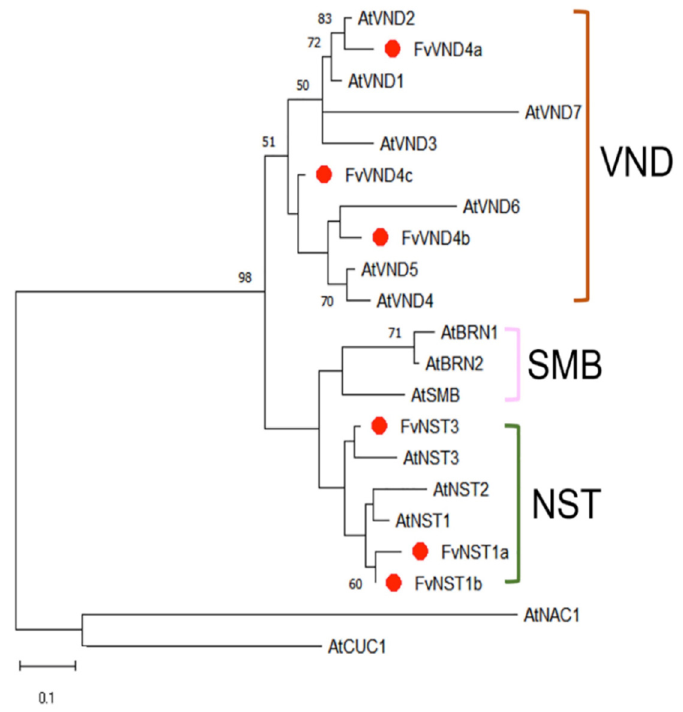
Figure 2. Phylogenetic tree of FvVNS and AtVNS proteins. The proteins were initially aligned using Clustal omega and then submitted for phylogenetic analysis using MEGA X software. The phylogenetic tree was constructed using the neighbor-joining method with 1000 bootstrap replications. Numbers indicate bootstrap values for the clades that received support values of over 50%.